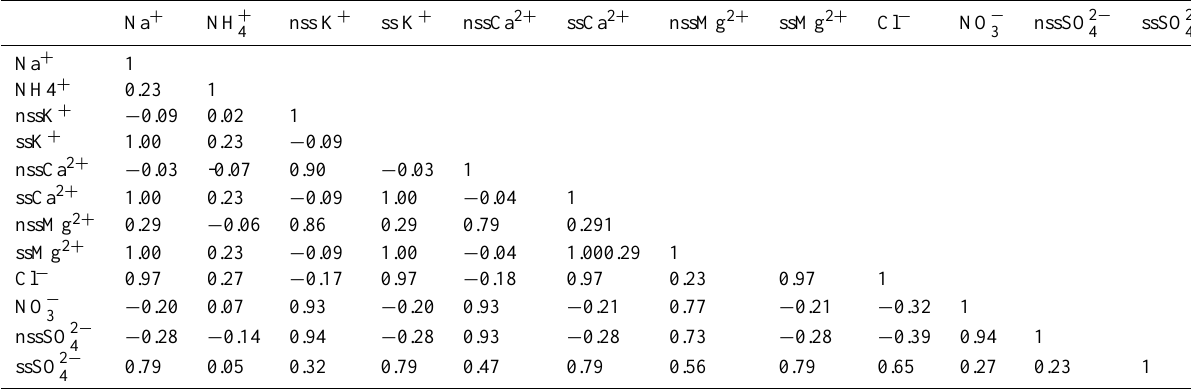
Table 6. Correlation coefficients ( r ) of major ions in summer aerosols from Cape Hedo, Okinawa.